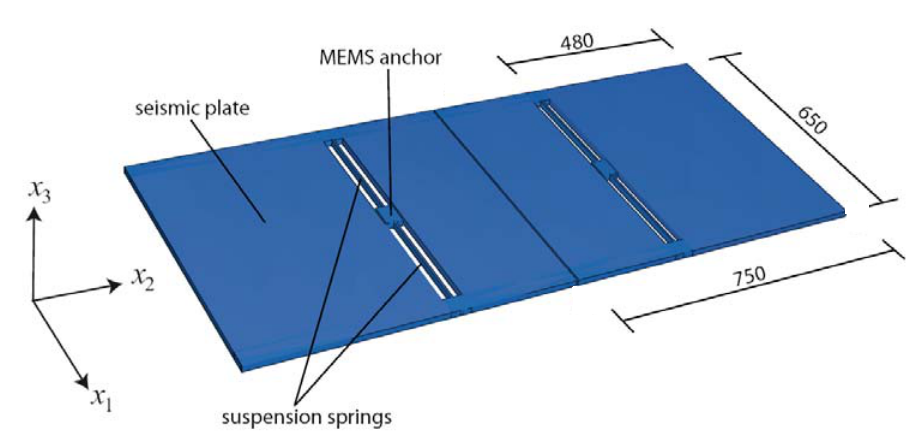
Figure 3. Geometry of the studied uni-axial accelerometers (measures in μ m; thickness of the seismic plates is 15 μ